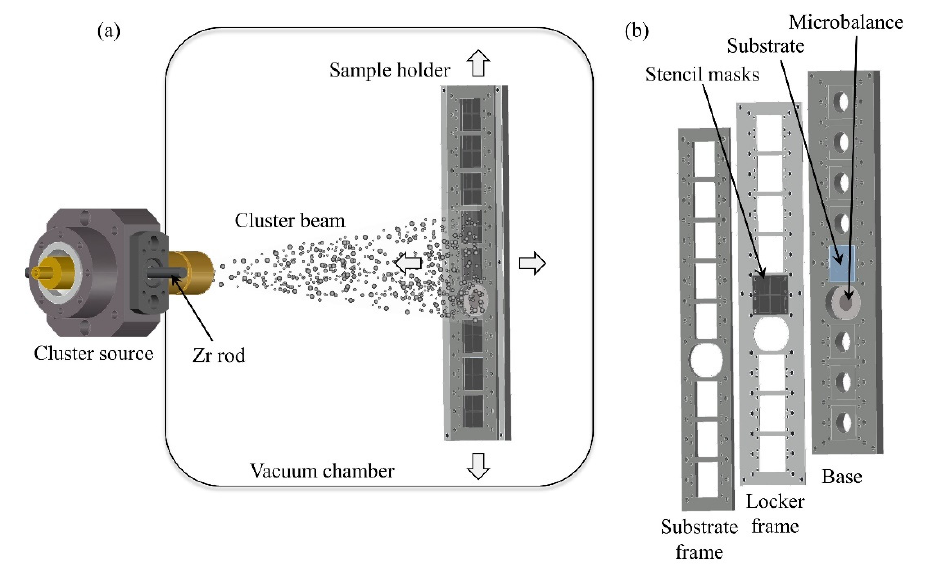
Figure 2. ( a ) Schematic representation of the SCBD apparatus (not to scale): the cluster beam is produced by the pulsed microplasma cluster source (PMCS) equipped with a zirconium rod and it impinges on the sample holder. By rastering the sample holder, a patterned film is deposited on all the samples. ( b ) Design of the sample and stencil mask holder. The three parts ensure the right positioning of the stencil masks with respect to the deposition substrates.